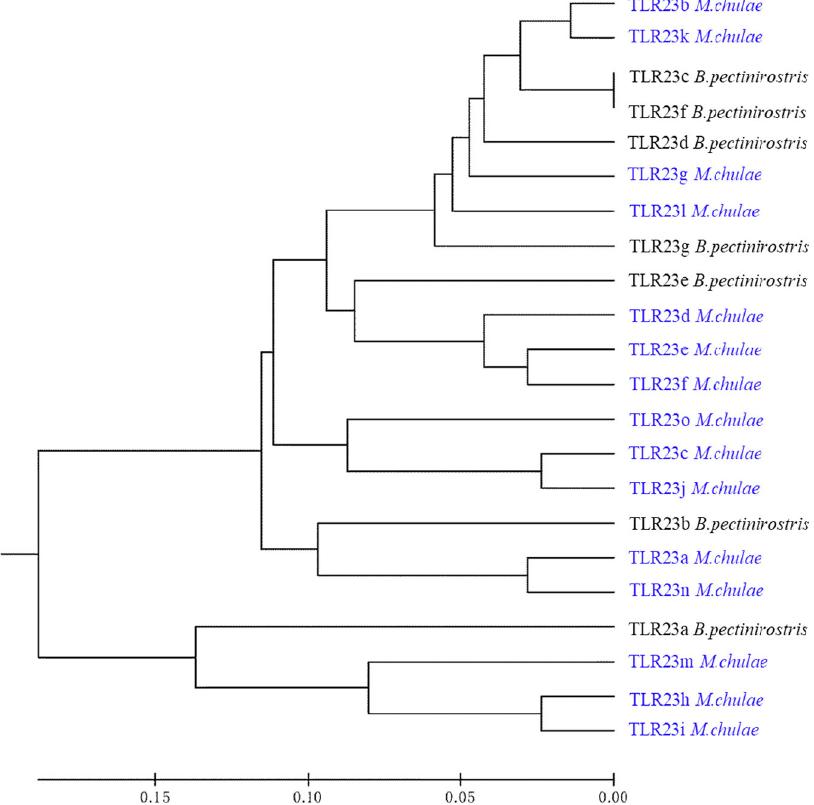
Fig. 6 Phylogenetic tree of TRL23 between yellowstripe goby and B. pectinirostris . TLR23 genes of yellowstripe goby are highlighted in blue. Phylogeny of TLR23 family between yellowstripe goby and B. pectinirostris showing the expansion of TLR23 in yellowstripe